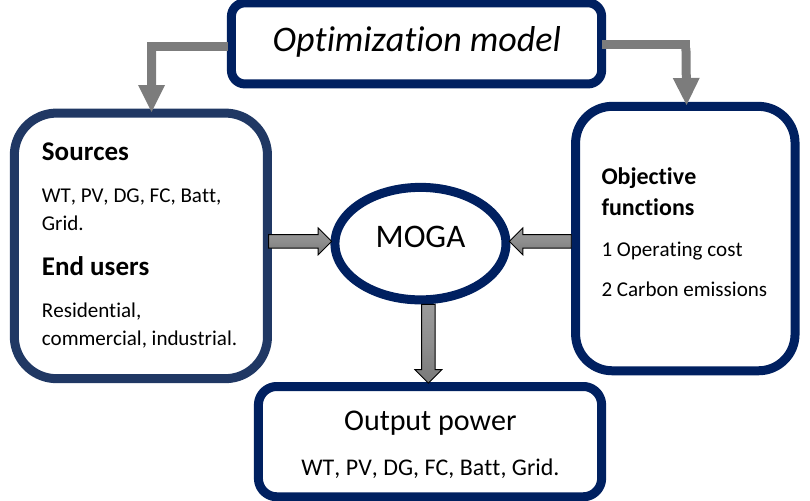
Figure 1. Proposed multi-objective energy optimization